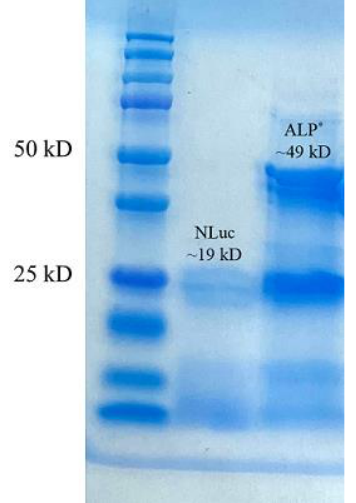
Figure 1. Detection of NLuc and ALP* in the soluble fraction of E. coli Bl21.